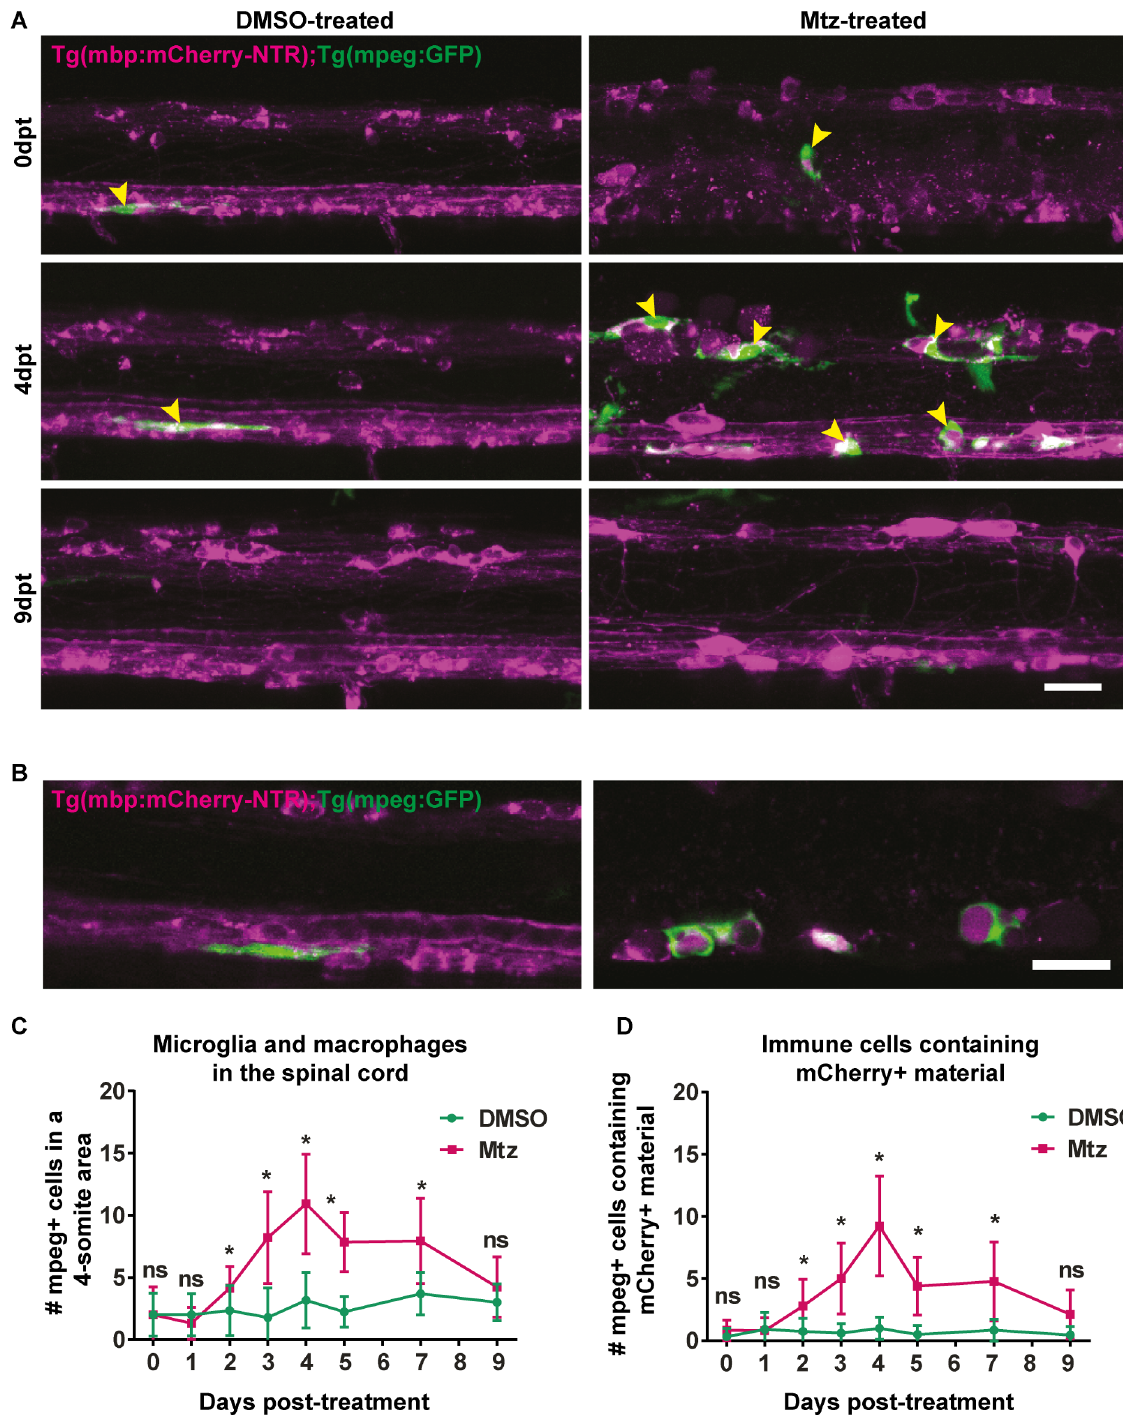
Fig 5. Macrophage and microglia response to oligodendrocyte ablation. A . Representative images of spinal cords of DMSO- or Mtz-treated Tg(mbp:mCherry-NTR) larvae, Green cells are mpeg-expressingmicrogliaand macrophages. Yellow arrowheads indicate examplesof mpeg+ cells in contact with the spinal cord. B. Singlez-plane images from DMSO- or Mtz-treated Tg(mbp: mCherry-NTR) larvae, Green cells are mpeg-expressing microgliaand macrophages and can be seen to surroundmCherry positive structures in Mtz-treated animals. C . Quantificationof mpeg+ cells in contact with the spinalcord (from a four-somite stretch of the spinal cord) At 0dpt, mean in controls: 2.0 ± 1.73 vs treated: 2.0 ± 2.26, p > 0.9999. At 1dpt, controls: 2.0 ± 1.71 vs treated: